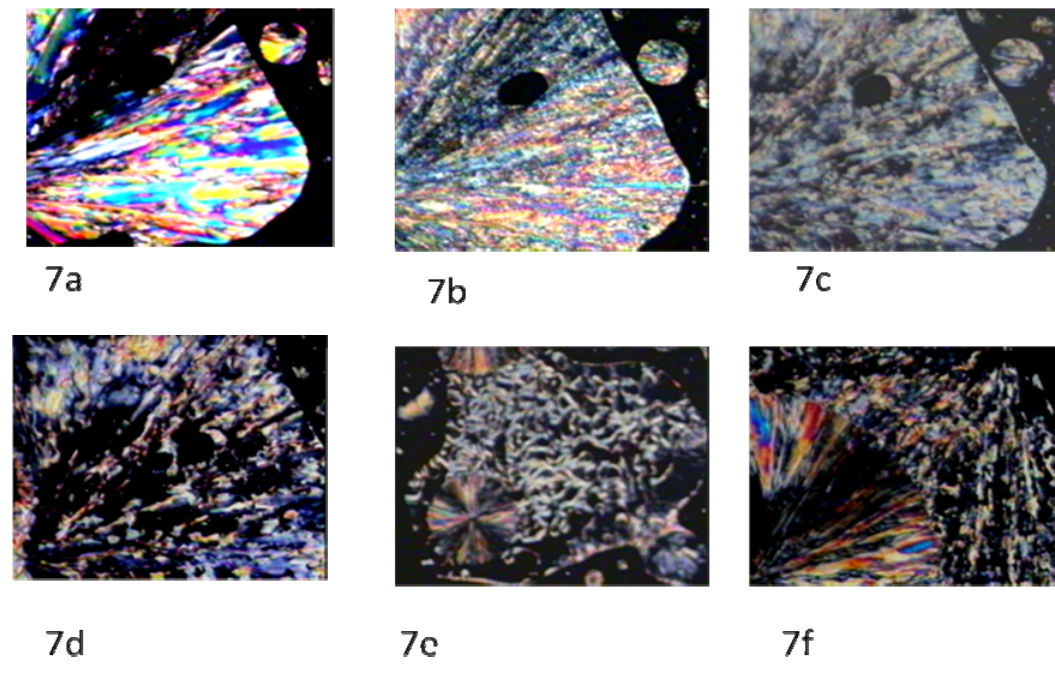
Figure 7. (7a) Initial crystalline texture of the mesogen; cross polarizers, 25 ° C, × 150. (7b) Crystalline-Nematic transition; crossed polarizers, 90.5 ° C, × 150. (7c) Nematic phase; 91 ° C, × 150. (7d) Nematic-Isotropic transition upon heating. The black domain represents the isotropic phase; crossed polarizers, 139 ° C, × 150. (7e) Nematic-Crystalline transition upon cooling; crossed polarizers 36 ° C, × 150. (7f) Nematic-Crystalline transition; crossed polarizers 36 ° C, ×